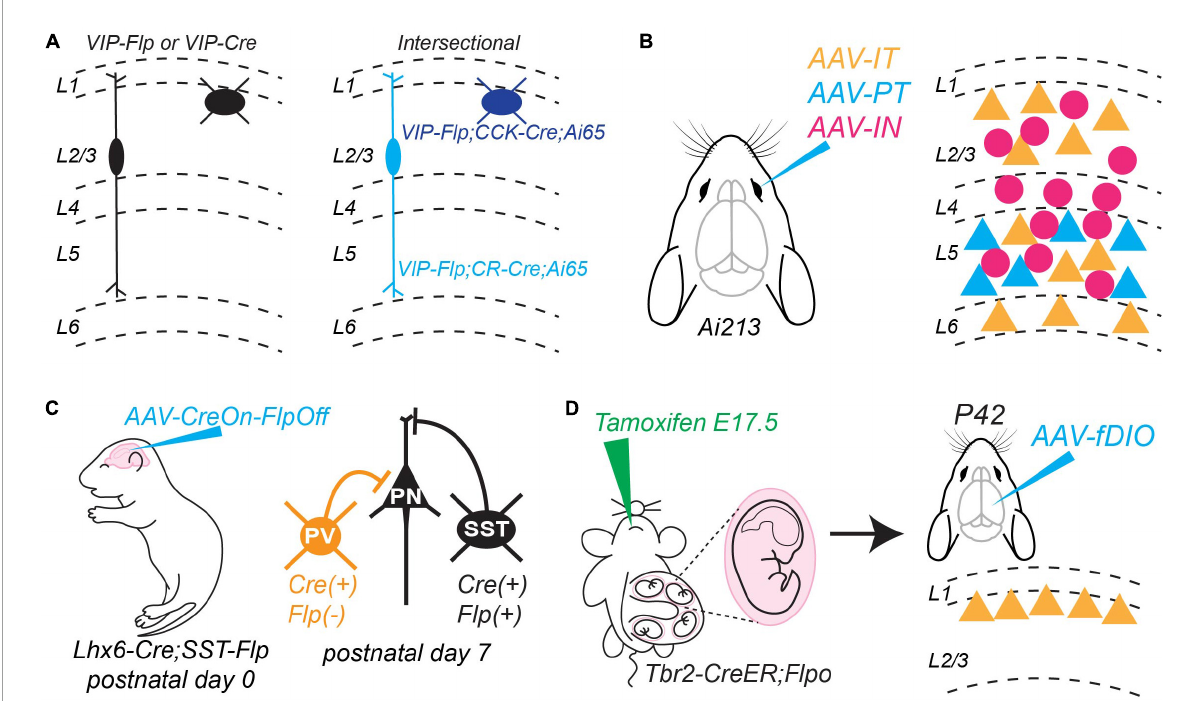
FIGURE1 New methods to target and manipulate neuronal cell types. (A) Intersectional Cre-Flp approach to target neuronal subtypes within a major class. Left . Diverse subtypes of vasoactive intestinal peptide (VIP)-expressing interneurons are captured by the VIP-Flp and VIP-Cre mouse lines. Right . Subtypes can be parsed by their co-expression of VIP and cholecystokinin (CCK) or calretinin (CR). These can be targeted experimentally by crossing VIP-Flp mice with CCK-Cre or CR-Cre mice, respectively. The Ai65 mouse line expresses the fluorophore tdTomato dependent on expression of both Flp and Cre. Described in He et al. (2016). (B) New AAVs to deliver constructs driven by enhancers unique to different neuronal classes. Up to three different enhancer-driven AAVs can be delivered by retro-orbital injection to an Ai213 mouse, which encodes three conditional fluorophores controlled by unique recombinases. In this example, the AAVs drive expression in IT-type projection neurons, PT-type projection neurons, and inhibitory interneurons throughout cortex. Described in Graybuck et al. (2021). (C) Injecting an AAV encoding a construct that is expressed in the presence of Cre but suppressed in the presence of Flp allows intersectional targeting of interneuron subtypes that are otherwise inaccessible during early postnatal development. Here, the “parvalbumin (PV)” interneuron class does not yet express PV but can be targeted for experiments. Described in Pouchelon et al. (2021). (D) New tamoxifen-inducible Cre mouse lines generated by Matho et al. (2021) will allow different subtypes of excitatory projection neurons to be fate-mapped during embryogenesis and then studied during